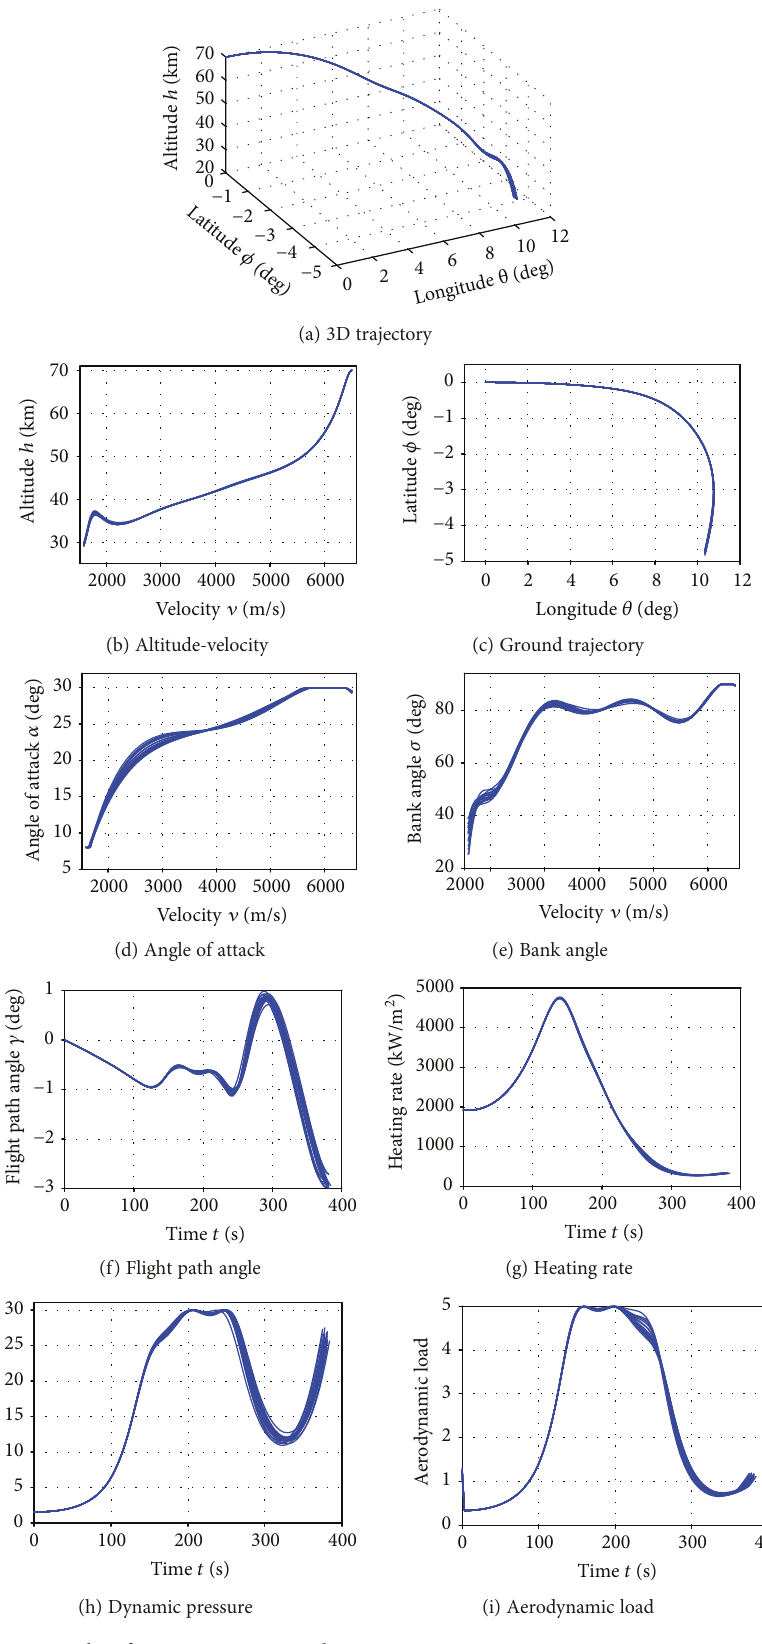
Figure 7: Simulation results of 20 times minimum downrange reentry trajectory optimization using the